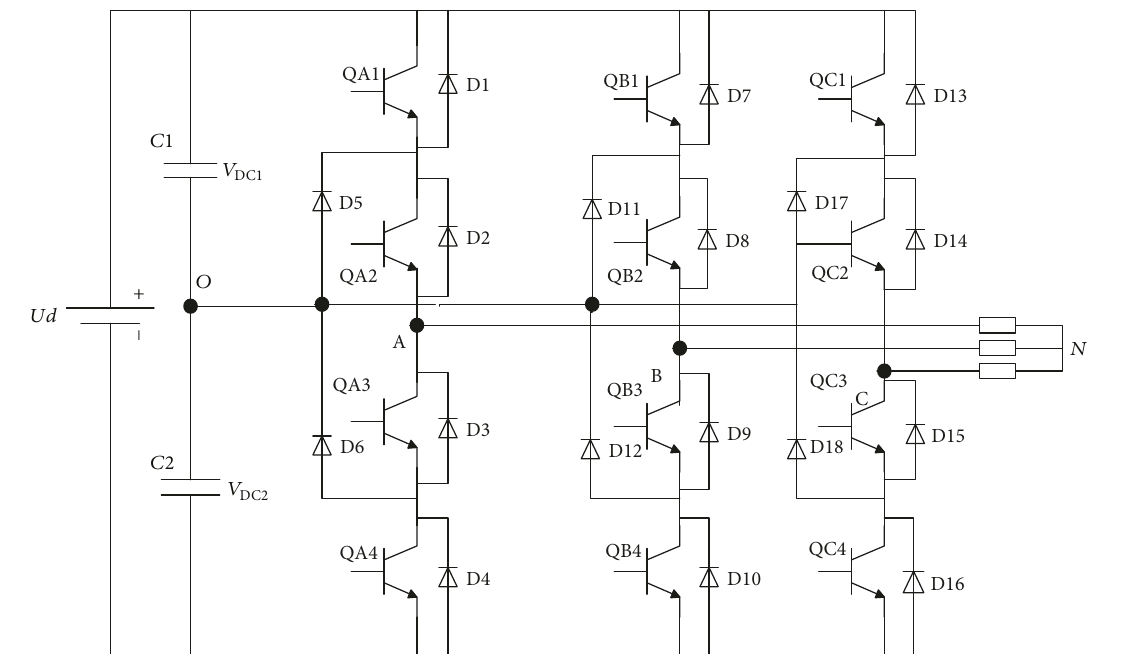
Figure 1: The main circuit of NPC three-level